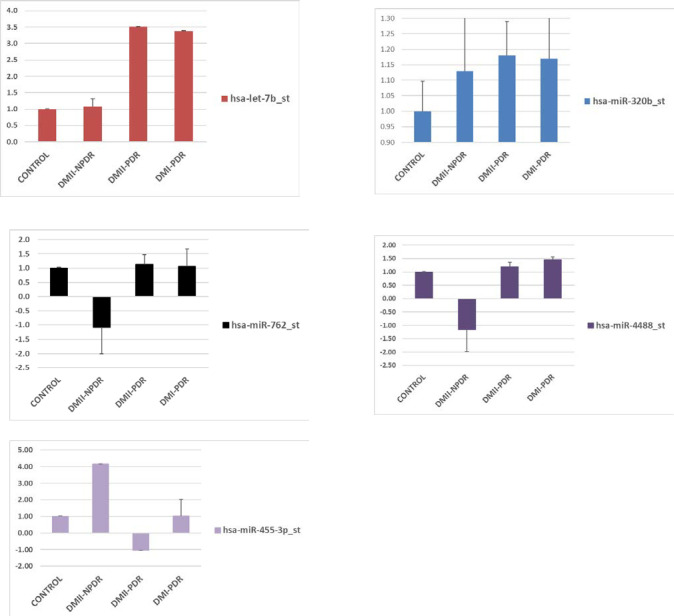
Select set of differentially expressed miRNA in aqueous in DRI-PDR, DRII-PDR and DRII-NPDR.